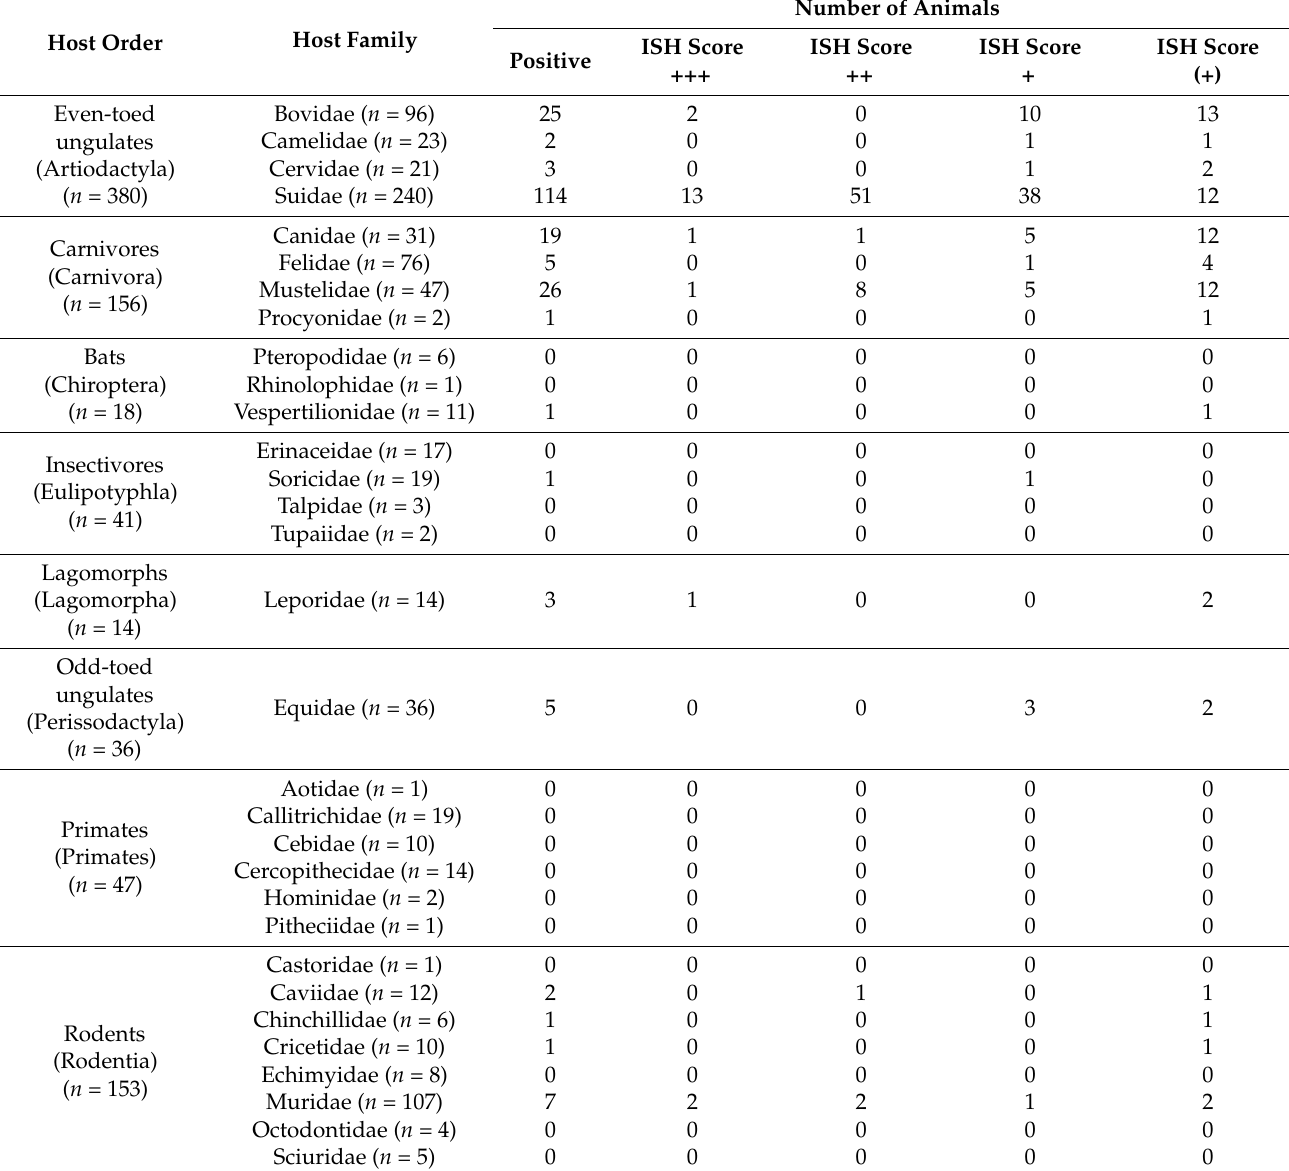
Table 1. Number of Pneumocystis -positive samples and semiquantitative ISH results for Pneumocystis spp. in each mammal